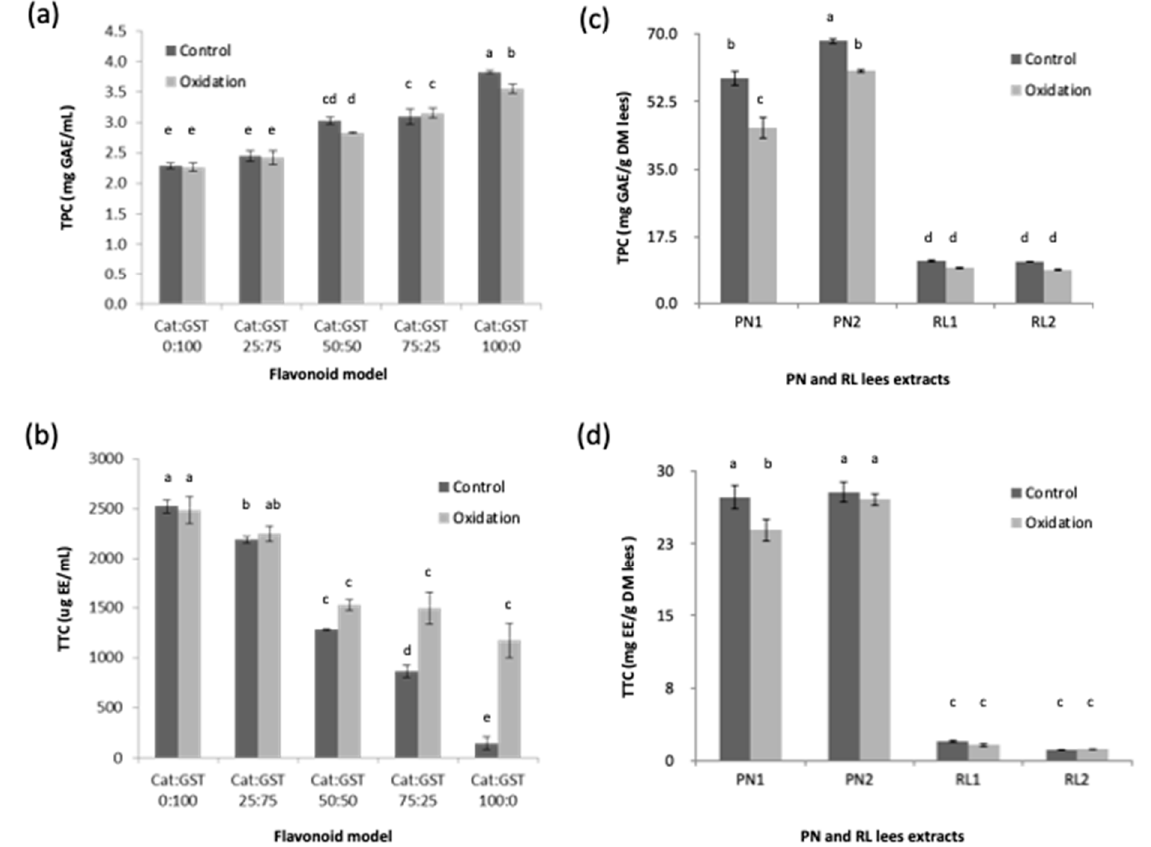
Figure 1. Total phenol content (TPC, mg GAE/mL) and total tannin content (mg EE/mL) of flavonoid model ( a , b ) and Pinot noir (PN) and Riesling (RL) wine lees extracts ( c , d ) exposed to oxidation with H 2 O 2 and horseradish peroxidase (oxidized) and not exposed to oxidation (control). Means